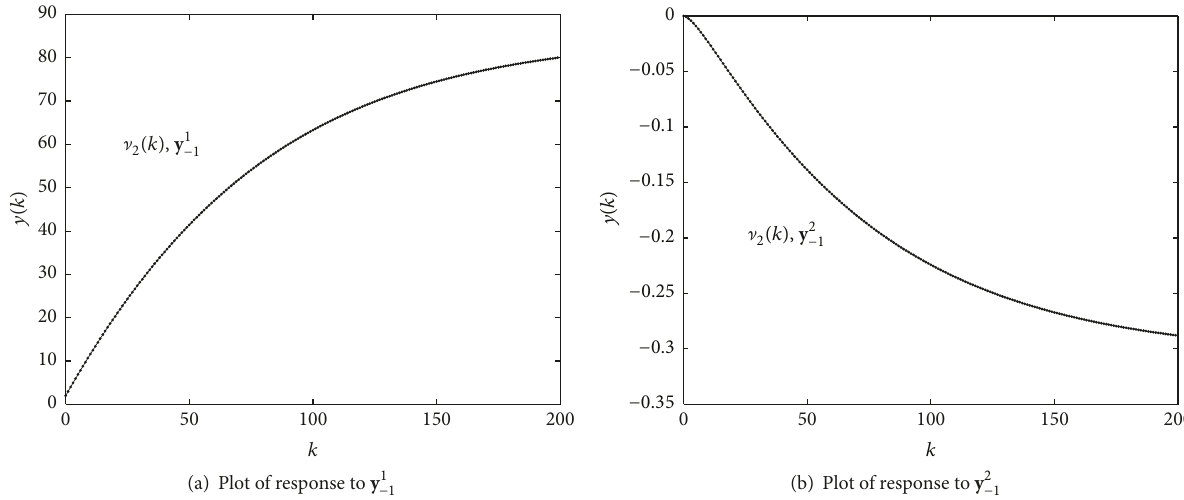
Figure 8: The VFOI homogenous responses to y 1 −1 and y 2 −1 with 𝑏 0 = 0.001, 𝑘 0 = 0 in formula (34) and the order ] 2 (𝑘) = 1 + 𝑒 −0.01𝑘 .